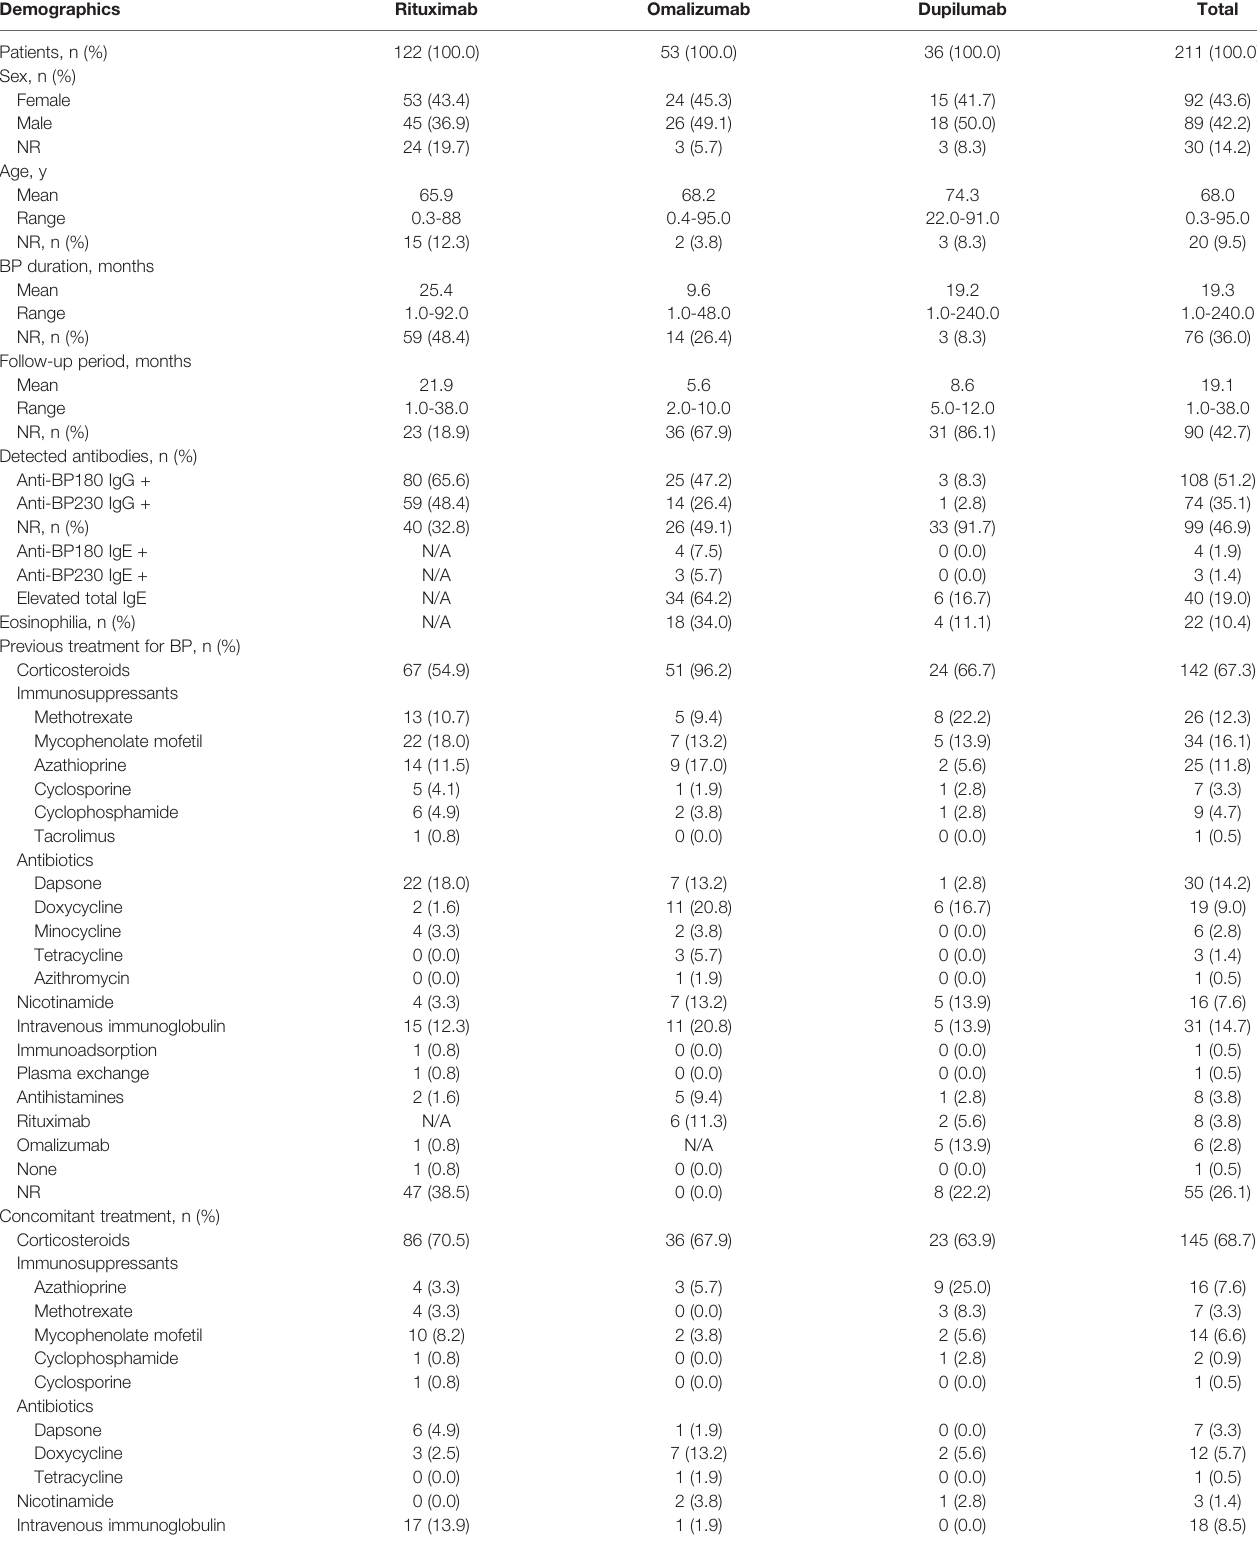
TABLE 1 | Summary of demographic information in patients with